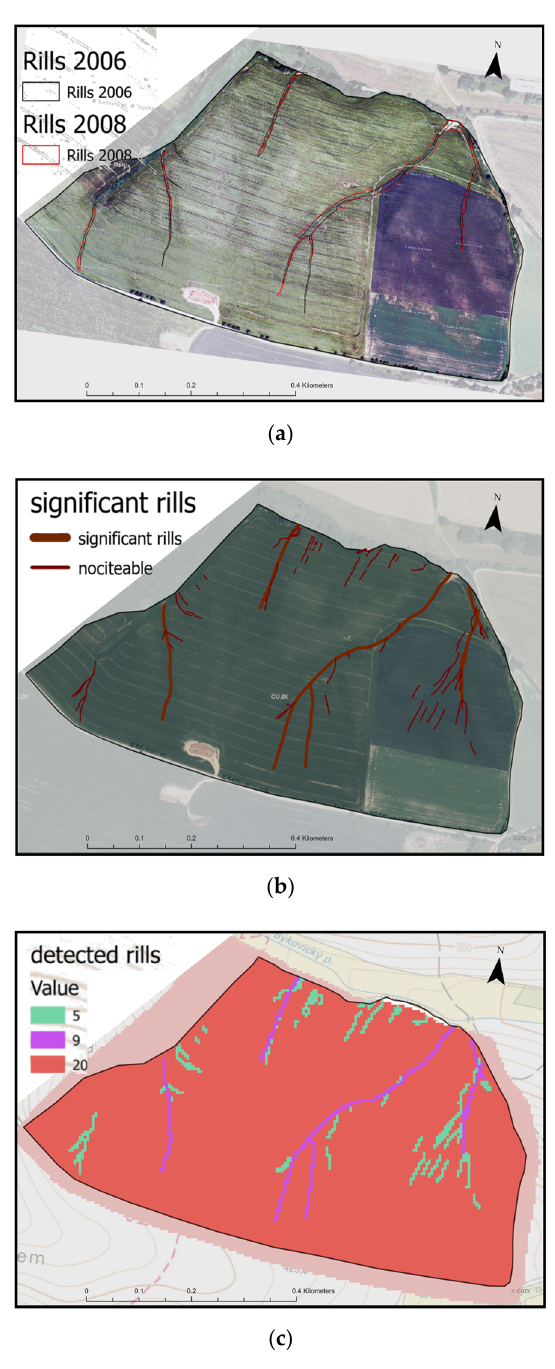
Figure 8. Detection of rills. ( a ) visually identified rills [53]. ( b ) Vectorization of significant (SR) and noticeable rills (NR). ( c ) Raster conversion for a pixel-by-pixel comparison.